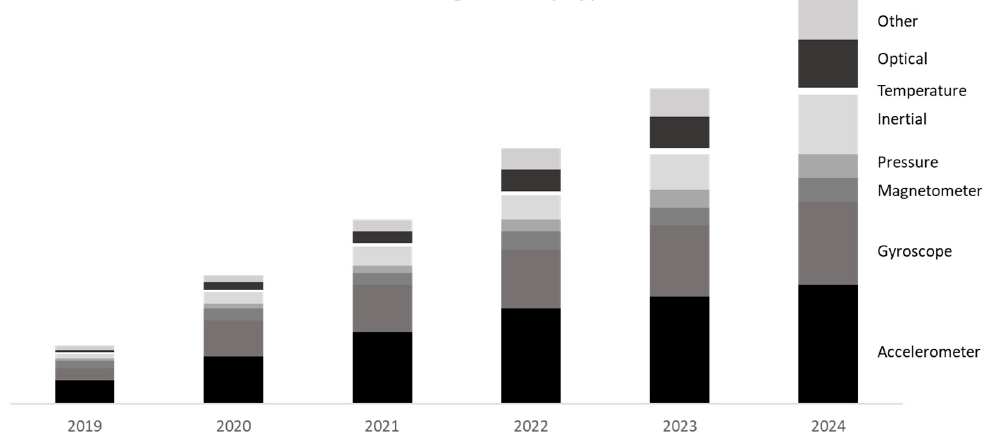
Figure 4. Sensors market share; data adapted from Grandview Research [12].